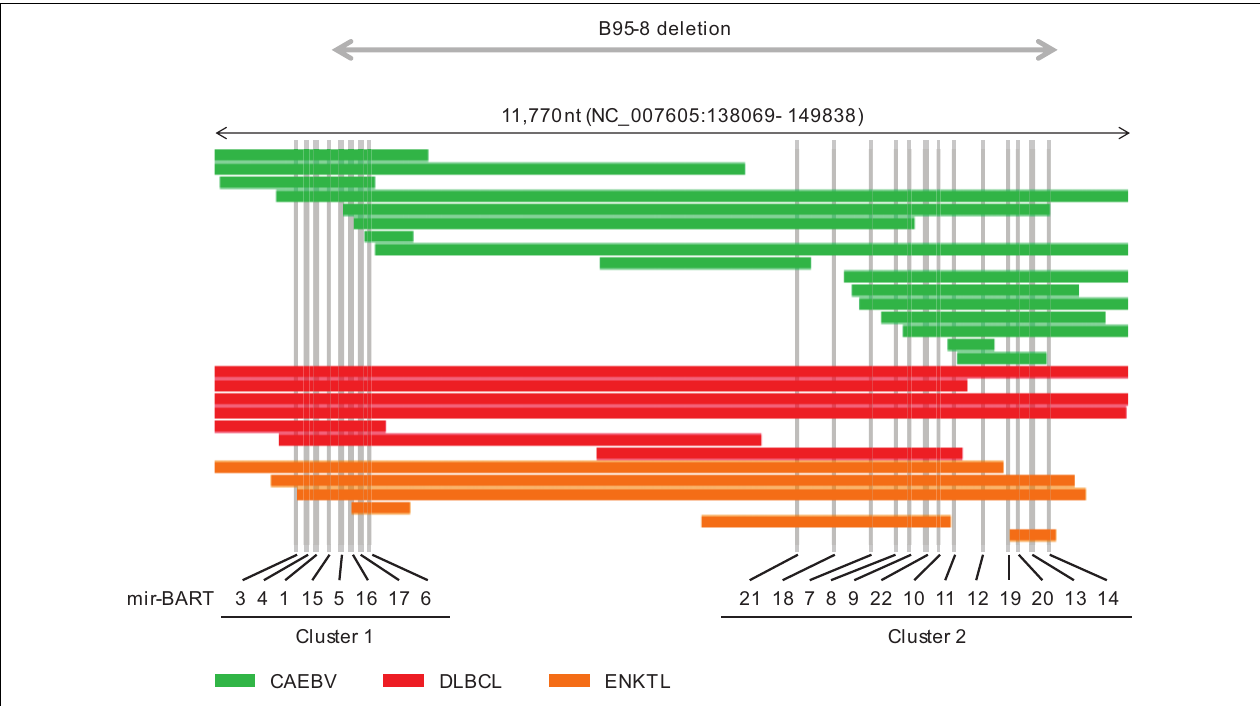
FIGURE 1 | Distribution of intragenic deletions in Bam HI-A rightward transcript (BART) microRNA clusters 1 and 2. CAEBV; chronic active EBV disease of T/NK type, DLBCL; diffuse large B cell lymphoma, not otherwise specified, ENKTL; extranodal NK/T cell lymphoma, nasal